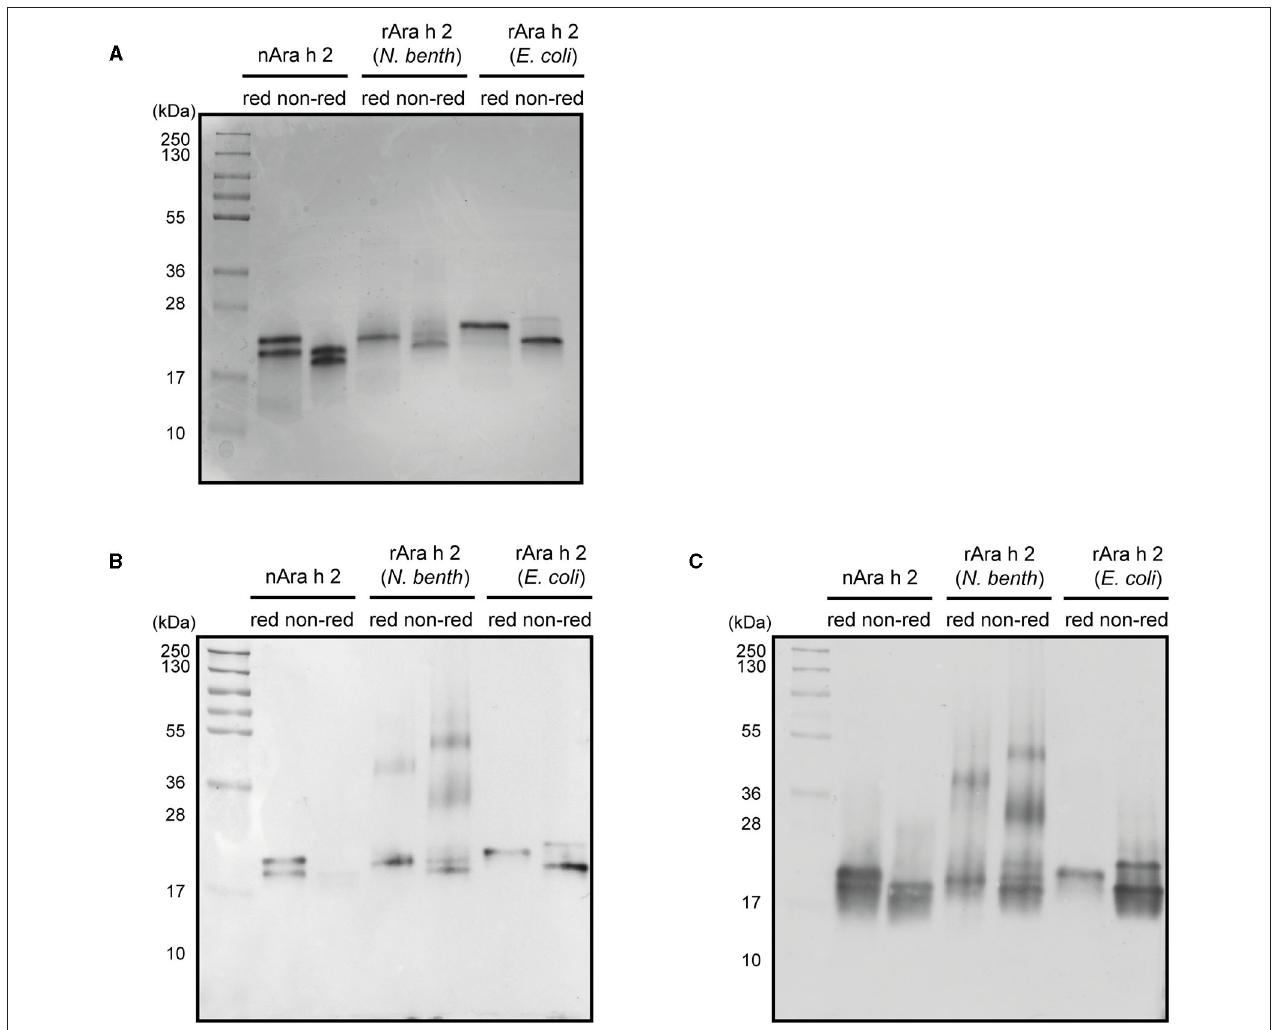
FIGURE 3 | Characterization of nAra h 2, rAra h 2 ( N. benthamiana ), and rAra h 2 ( E. coli) . (A) The purity of nAra h 2, rAra h 2 ( N. benthamiana ), and rAra h 2 ( E. coli ) was visualized by CBB-stain after running 2 µ g protein per lane on SDS-PAGE under reducing (red) and non-reducing (non-red) conditions. (B) All three proteins were detected using a monoclonal anti-Ara h 2 antibody, loaded as in (A) . (C) A pool of sera of peanut-allergic patients ( n = 5) was used to detect all Ara h 2 proteins, loaded as in (A)